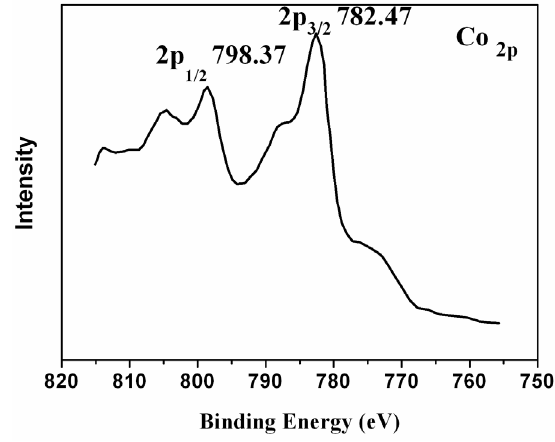
Figure 1. X-ray photoelectron spectra (XPS) pattern of silica/cobalt hydroxide nanocomposite.